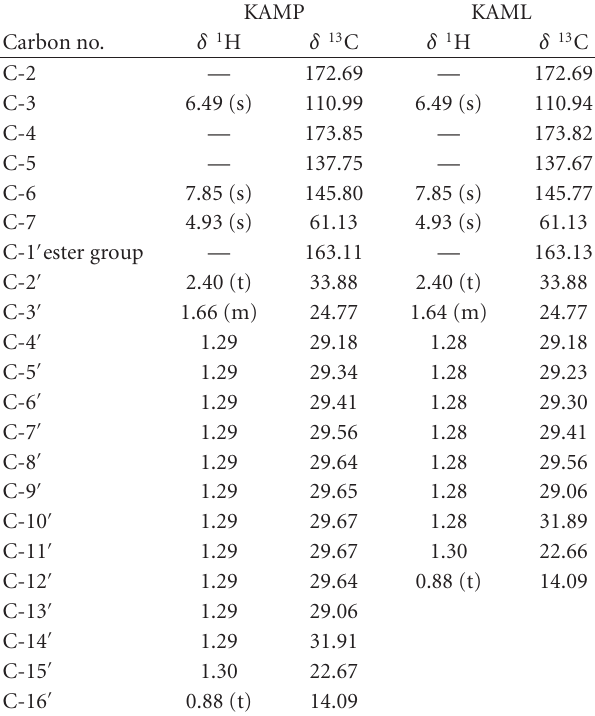
Table 2: 1 H-NMR and 13 C-NMR data for KAMP and KAML.